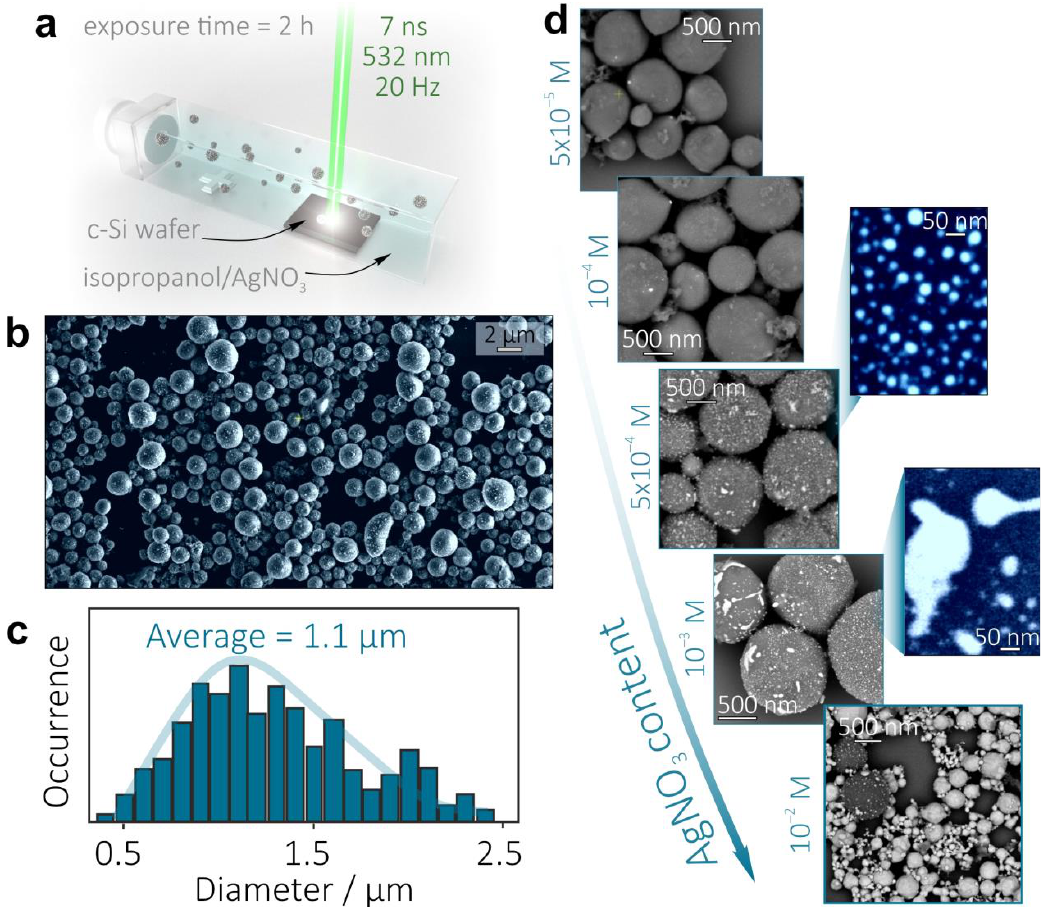
Figure 1. ( a ) Schematic of the PLAL synthesis of Ag-Si microspheres upon ns-laser ablation of the monocrystalline Si wafer placed in the isopropanol containing AgNO 3 . ( b ) Top-view SEM image of the as-synthesized Ag-Si product dried on a Si wafer. ( c ) Size distribution of the Ag-Si microspheres. ( d ) Series of SEM images illustrating evolution of the density and geometry of the Ag nanoclusters on the surface of Si microspheres upon increase of the AgNO 3 content in the working solution from 5 × 10 −5 to 10 −2 M.